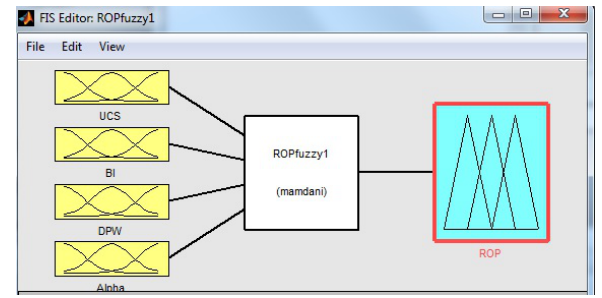
Figure 8: Design of fuzzy logic model.